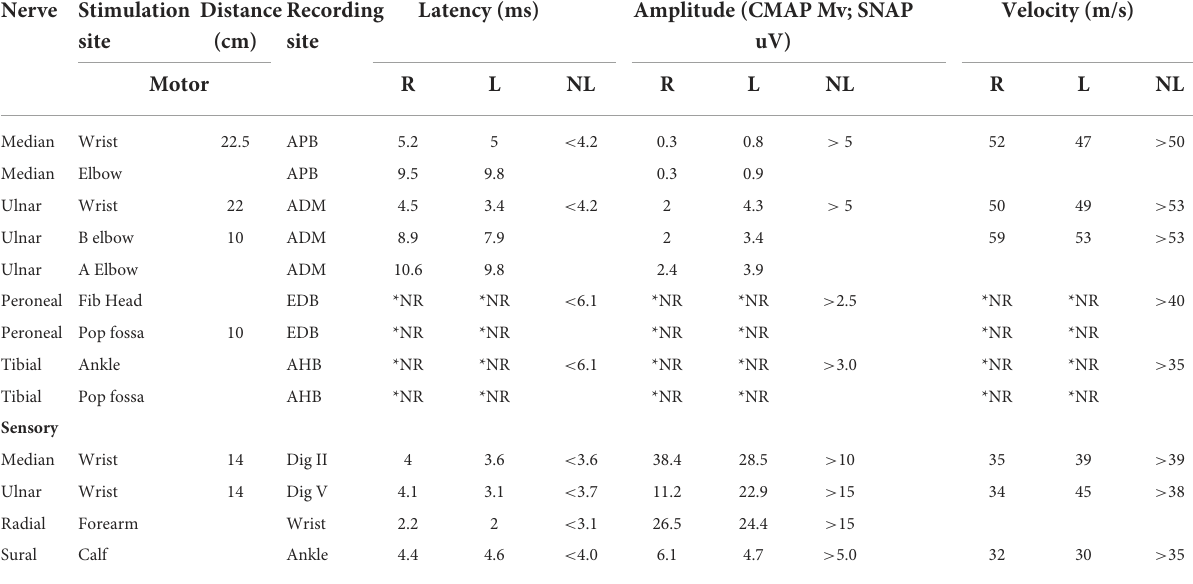
TABLE 1 Motor and sensory nerve conduction studies of the bilateral upper and lower